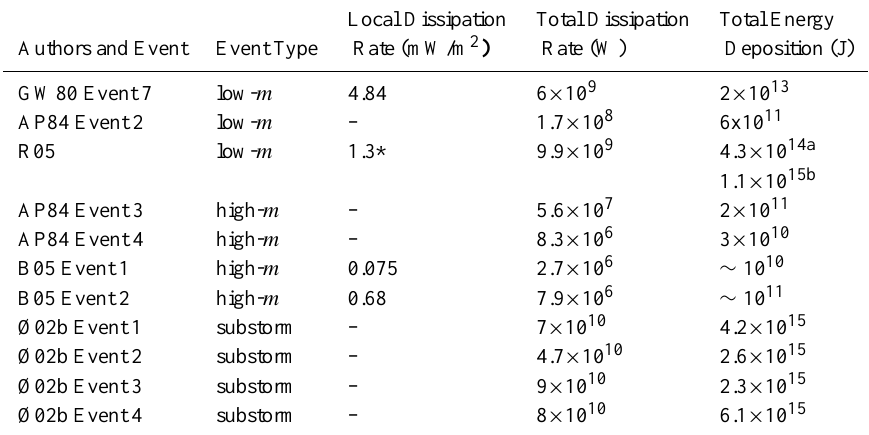
Table 2. A comparison of the previous work on energy deposition into the ionosphere via Joule heating. For the AP84 values, we assume that the total energy deposition is an hourly rate (through comparison with the GW80 event 7). For comparison, the work of Ø02b are included, who studied the Joule heating during a substorm